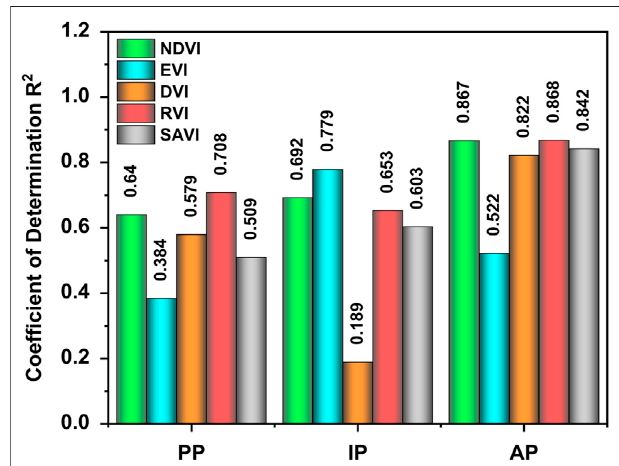
FIGURE 8 | Comparison of regression coef fi cients of vegetative indices in urban greenery types.